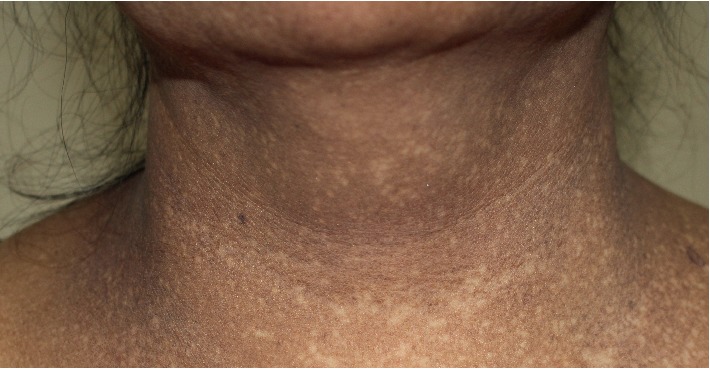
Guttate hypopigmentation in LPP.